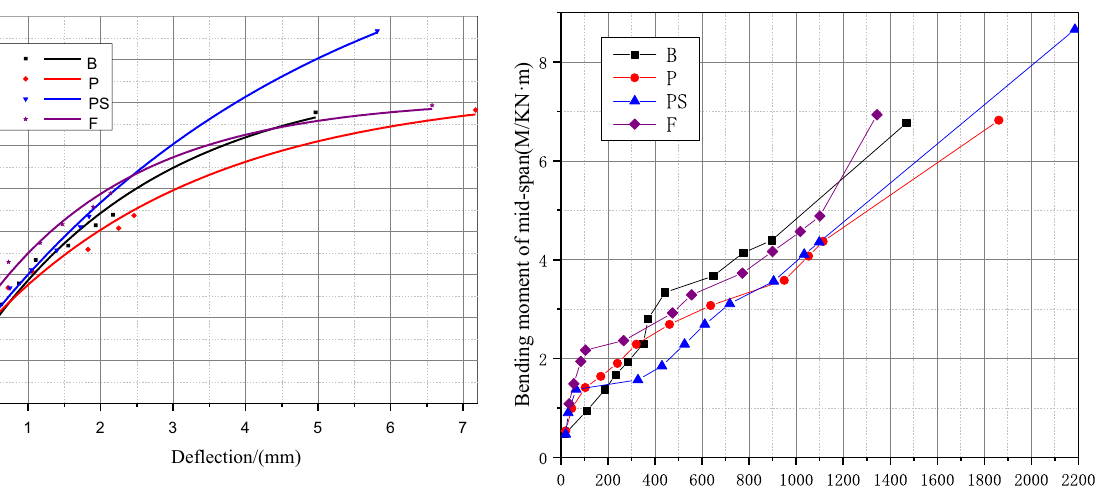
Figure 6: Relationship between the de fl ection and the bending moment of mid - span.